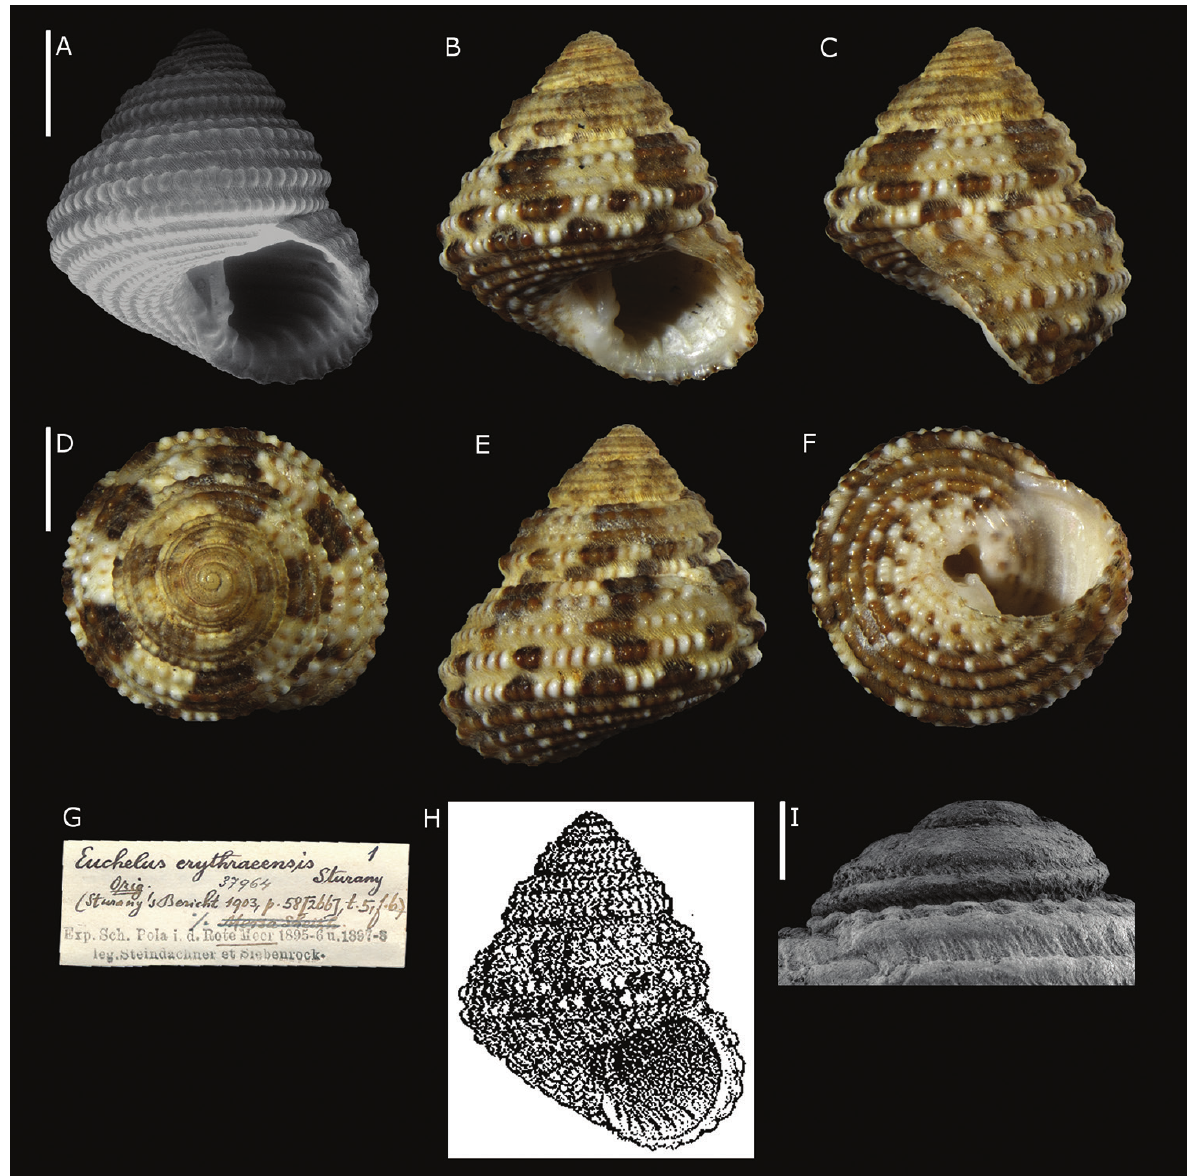
Figure 2. Euchelus erythraeensis Sturany, 1903, Locality 10 (Nawibi, Gulf of Aqaba, Red Sea). A–F, I . Lectotype, NHMW 37964: front ( A–B ), right side ( C ), top ( D ), back ( E ), bottom ( F ), protoconch ( I ). G . Original lectotype label. H . Original figure by Sturany (1903). Scale bars: A–F : 2 mm, I : 0.2 mm.